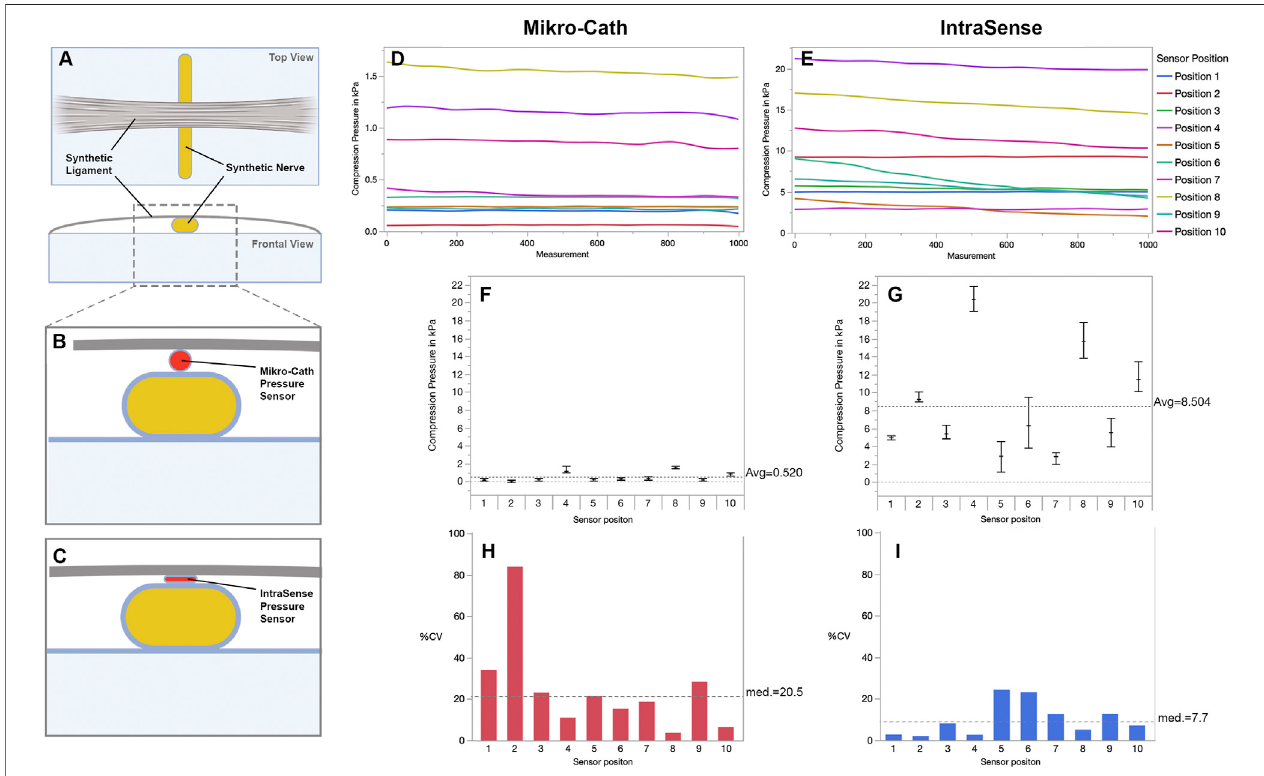
FIGURE 3 | Perineural pressure measurement in a synthetic nerve compression model (A) Experimental set-up using a synthetic nerve and ligament to simulate nerveentrapment (B,C) Thesensor isinsertedintothe entrapment site and positioned betweennerveand ligamenttomeasure thepressurethatisexertedon thenerve (D,E) Serial nerve compression pressure measurements in ten individual sensor positions. Even though the examiner tried to recreate the same sensor position each time, the detected pressure differed signi fi cantly between positions (F) The average compression pressure (±SD) per sensor position measured with the Mikro- Cath and (G) Intrasense respectively. Notably, the fl at shaped Intrasense measures consistently higher pressure values as compared to the Mikro-Cath (H) Measurement variability of the Mikro-Cath and (I) Intrasense expressed as precent coef fi cient of variation (%CV) for each individual sensor position, indicating greater variability in Mikro-Cath measurements. Figures were designed with